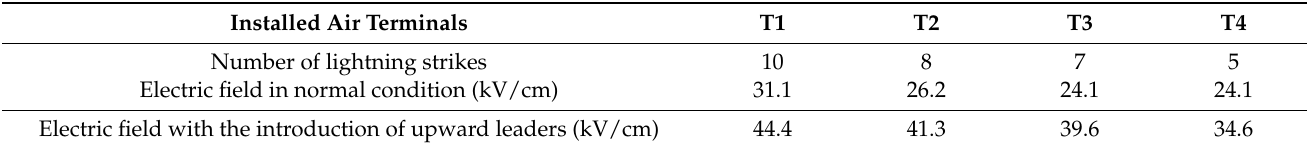
Table 5. Number of strikes and electric field on the LATs of a square-shape